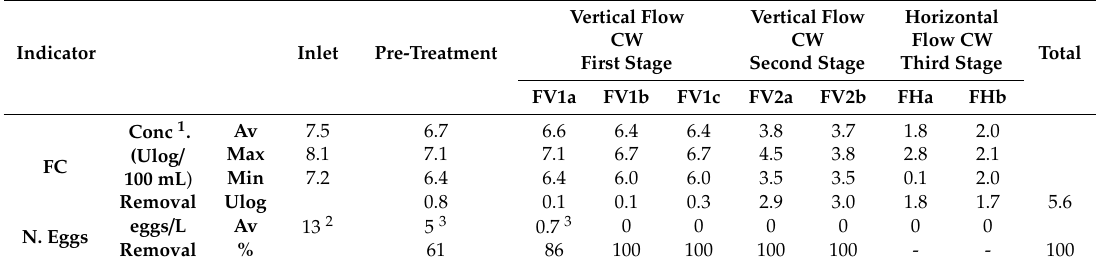
Table 5. Microbiological indicator (fecal coliforms and nematode eggs) concentration and removal.